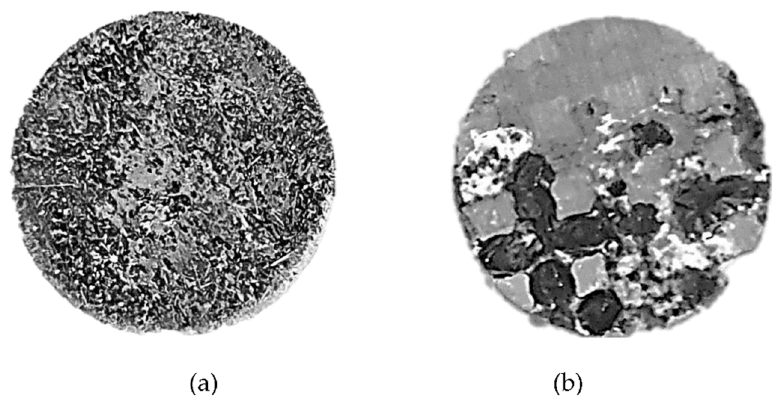
Figure 9. General appearance of corrosion attack obtained after 14 days of immersion test: ( a ) Zn– 2%Fe alloy and ( b ) OI–TiZn system.